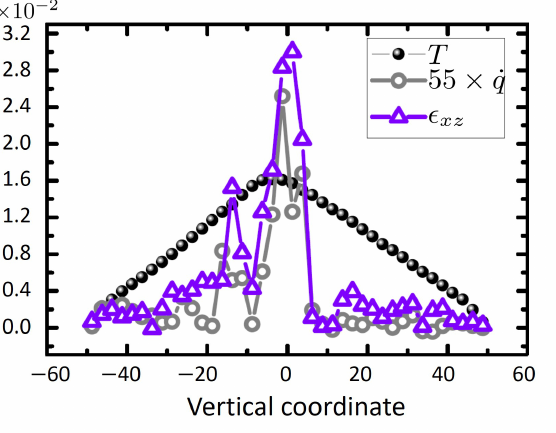
Figure 6. Temperature, local strain and heat production rate versus vertical coordinate z . As indicated in the curve legend, ˙ q is multiplied with a factor of 55 for better visibility. Within statistical fluctuations, the maxima of strain, heat production rate and temperature coincide, highlighting the close connection between these quantities. We have repeated this analysis for other slabs along the x -axis and observe the same trend (data not